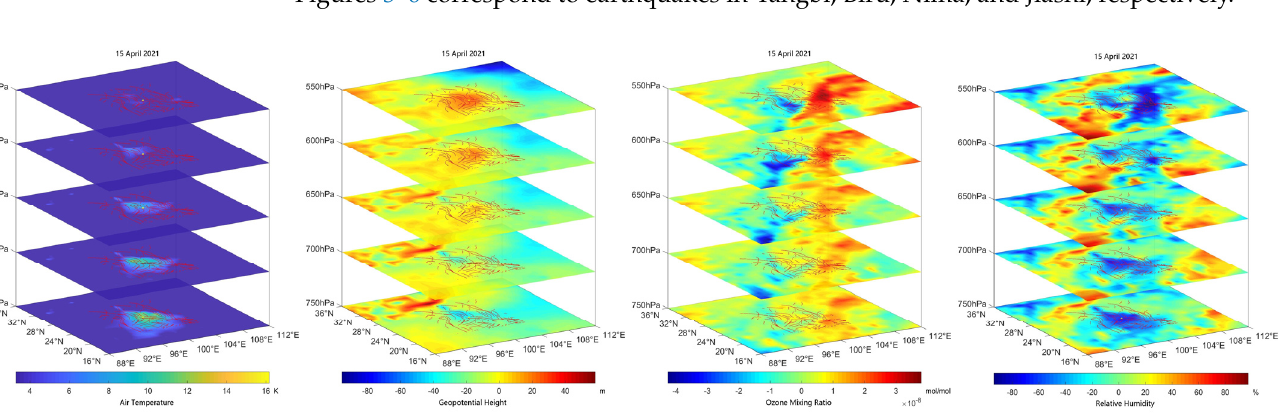
Figure 3. Composite atmospheric anomaly map associated with earthquake in Yangbi on 15 April. The epicenter and faults are shown by yellow point and red lines, respectively. For each row, the subplots represent air temperature, geopotential height, ozone mixing ratio and relative humidity from left to right.